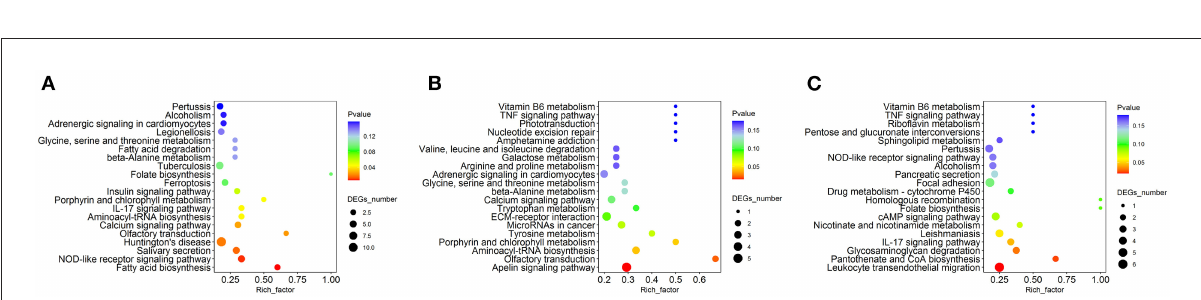
FIGURE5 Kyoto Encyclopedia of Genes and Genomes (KEGG) pathway analysis of differentially expressed MFGM proteins. (A) The KEGG pathway analysis of differential proteins in MP/LP treatment; (B) The KEGG pathway analysis of differential proteins in HP/MP treatment; (C) The KEGG pathway analysis of differential proteins in HP/LP